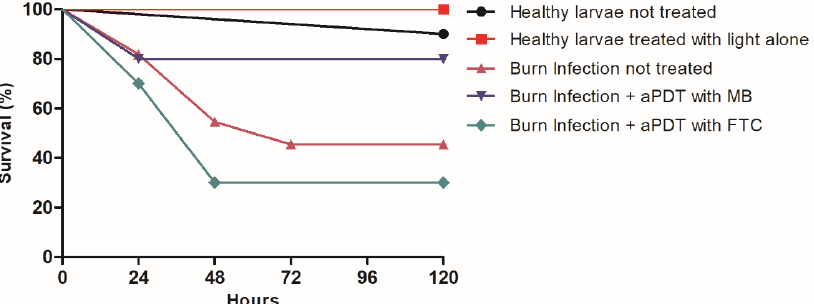
Figure 4. Survival curve of G. mellonella obtained in the following groups: healthy larvae not treated, healthy larvae treated with light alone, larvae with burn infected by A. baumannii and not treated, larvae with burn infected by A. baumannii and treated with MB-mediated aPDT, and larvae with burn infected by A. baumannii and treated with FTC-mediated aPDT. Comparison of survival curves by Log-rank test: no statistically significant differences were found for the groups “burn infection + aPDT with MB” ( p = 0.1827) and “burn infection + aPDT with FTC” ( p = 0.5780) in relation to “burn infection not treated”.